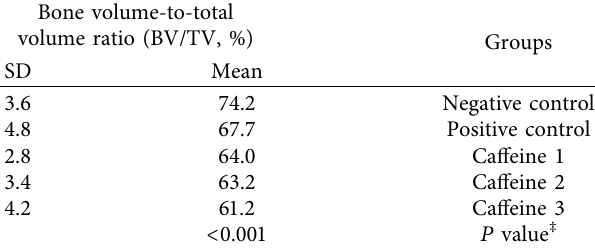
Table 3: Mean BV/TV ratios in the study groups. Bone volume-to-total volume ratio (BV/TV, %)